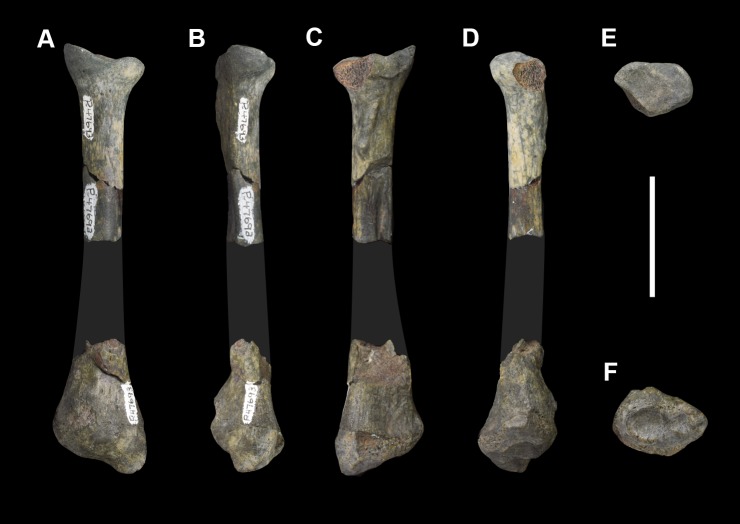
Right radius of Periptychus carinidens (NMMNH P-47693).(A) anterior view; (B) lateral view; (C) posterior view; (D) medial view; (E) proximal view, (F) distal view. Scale bar: 30mm.